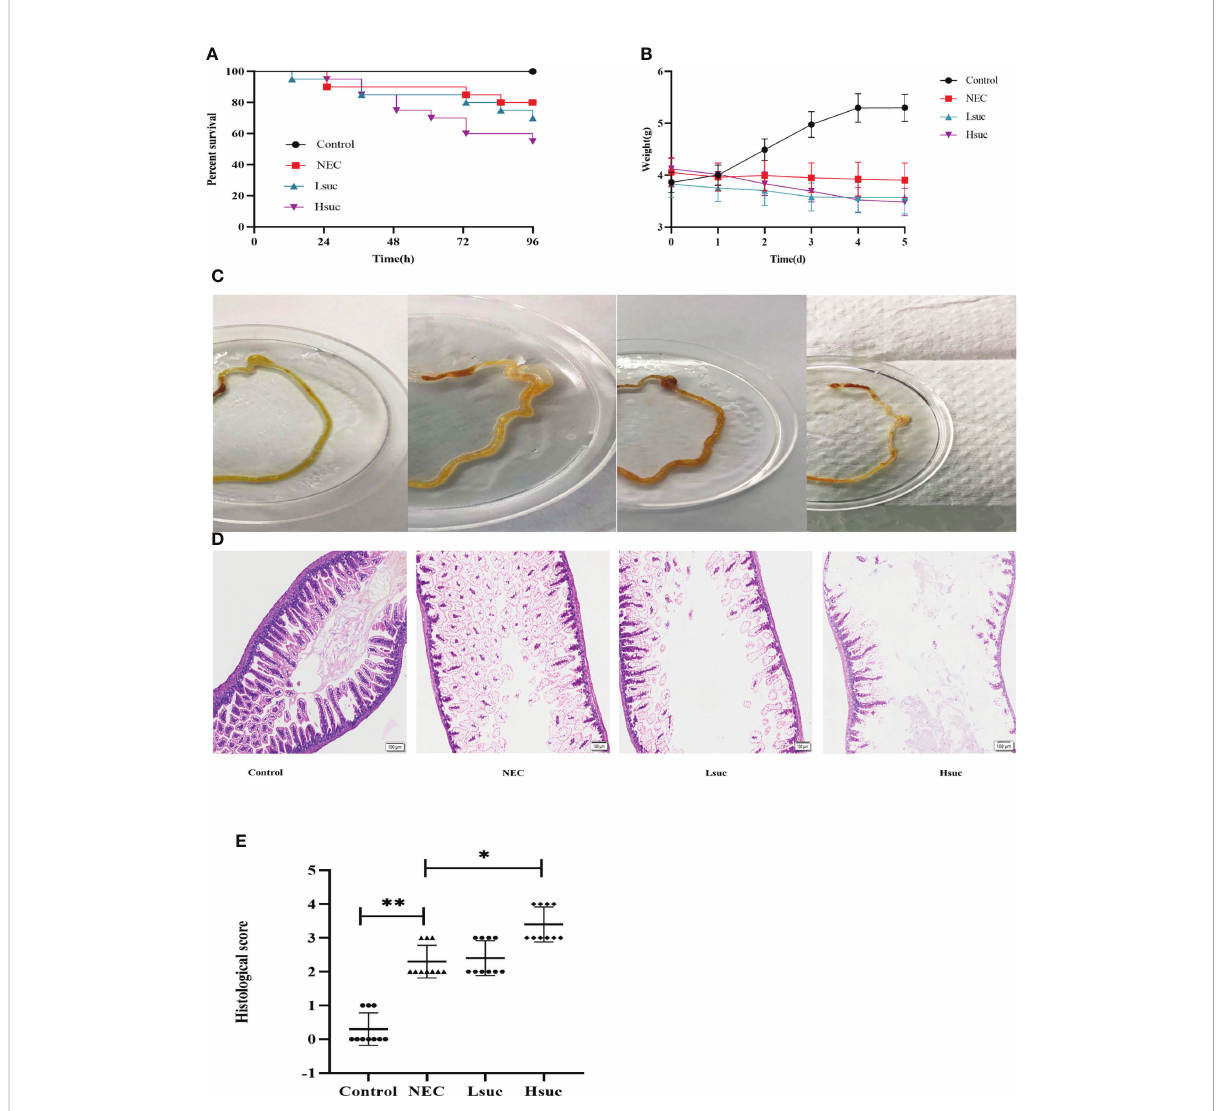
FIGURE 5 Succinate exacerbates experimental murine necrotizing enterocolitis. Data are from four independent experiments. (A) Percent survival in the four groups. Log-rank test P value: * P < 0.05. (B) Body weight changes in mouse pups in the four groups. Baseline differences in weight were not signi fi cant. Two-way ANOVA multiple-comparison method P value: * P < 0.05. (C) Representative morphological observations of intestinal tissue of each group immediately following excision at the time of the experimental endpoint. (D) Representative photomicrographs of terminal ileal sections from each of the four groups. Magni fi cation ×100; scale bars:100 m m. (E) Histological scoring of intestinal regions observed in the control, NEC, Lsuc and Hsuc groups. Kruskal – Wallis test P value: * P < 0.05, ** P <